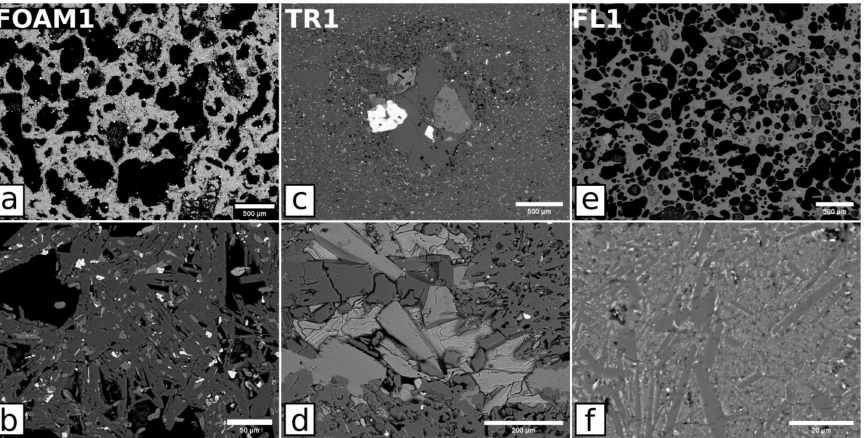
Figure 5. Backscattered electron images of FOAM1, TR1, and FL1 aphyric lavas at low ( a , c , e ) and high ( b , d , f ) magnification. FOAM1 ( a , b ) displays high vesicularity with bubbles having irregular walls shaped by microlites of the groundmass. Images of TR1 ( c , d ) show at microscale the nature of the banding given by HB and LB areas, i.e., the former given by microlites of feldspar, and the latter characterized by the association of microlites, microphenocrysts (feldspar, pyroxenes, oxide, and anhydrite), and vesicles. The FL1 lava ( e , f ) displays abundant vesicularity with spherical and sub-spherical bubbles in a fine groundmass showing also the presence of glass.